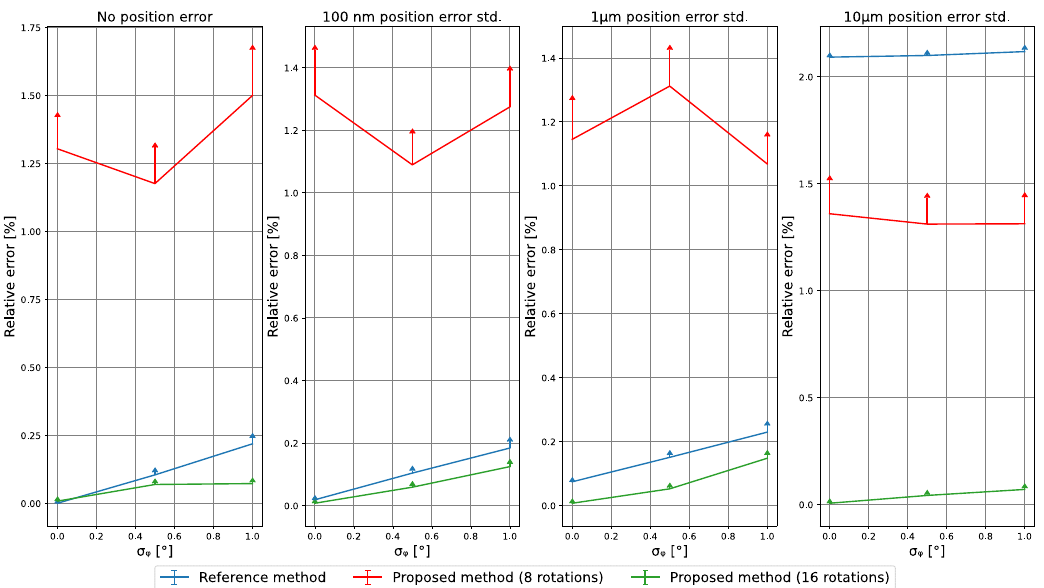
Figure 5. Relative RMS error of the reference and the proposed methods for independent error case. The vertical axis shows the relative error between each result and the ground truth. The horizontal axis shows the misalignment error. The vertical arrows show the standard deviation of the measurement.